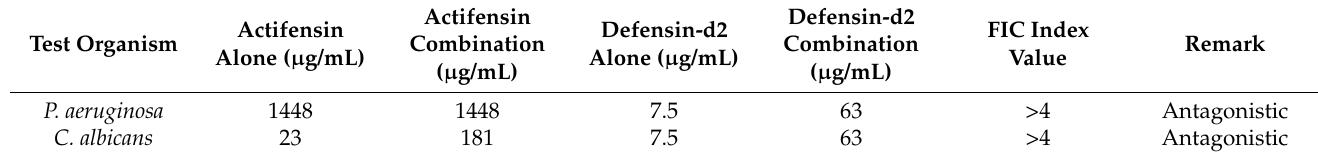
Table 2. Minimum inhibitory/bactericidal/fungicidal concentrations of recombinant actifensin and defensin-d2.